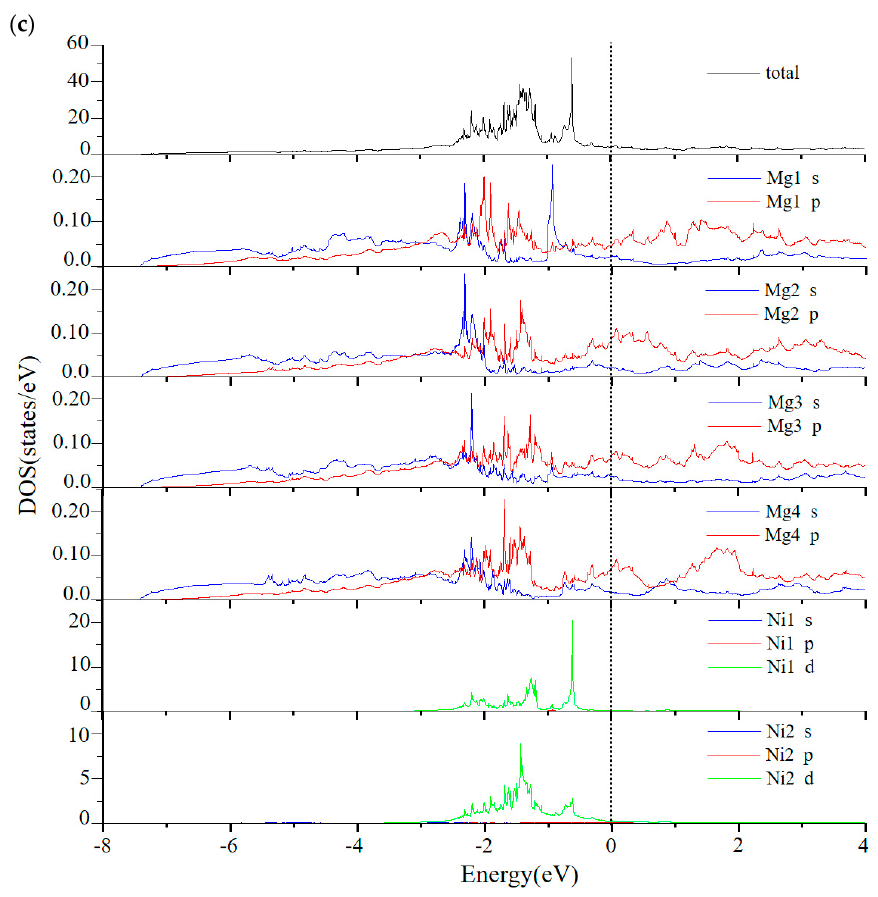
Figure 6. ( a ) The calculated equilibrium crystal structure, ( b ) electron localization function (isosurface level of 0.285), and ( c ) electronic density of states of Mg 2 Ni (the Fermi level is set at zero).